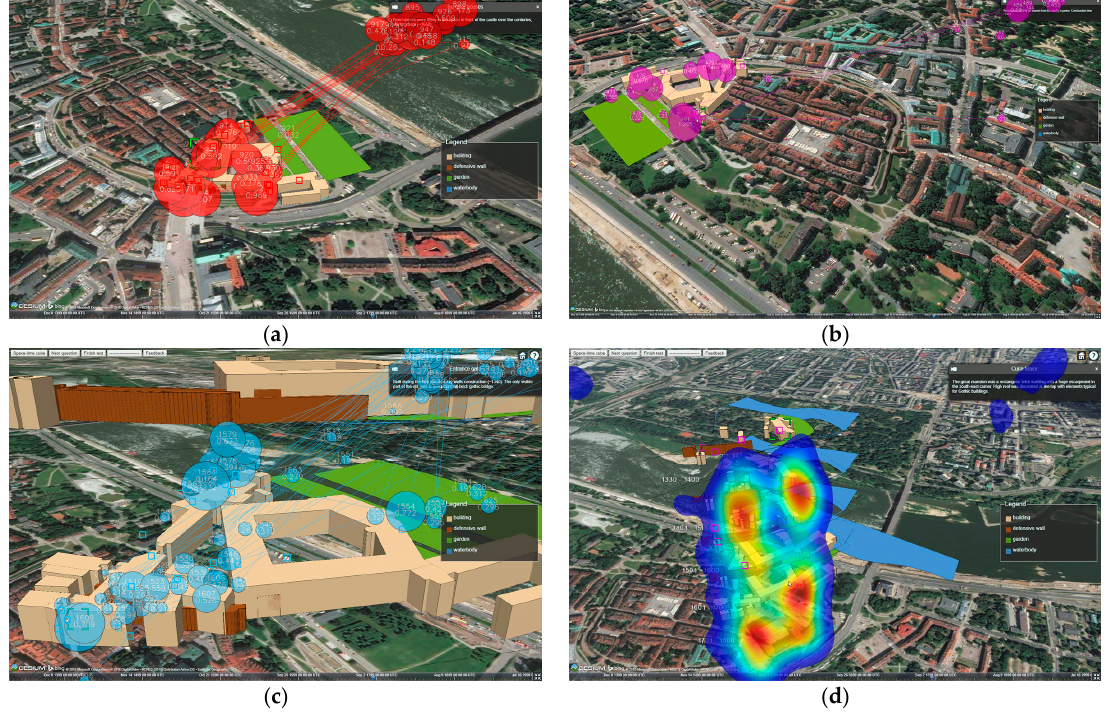
Figure 17. Searching strategies for Q4: ( a ) overview and details-on-demand in the slider-based visualization; ( b ) overview and details-on-demand in the slider-based visualization; ( c ) zoom and details-on-demand operations in the space–time cube; ( d ) overview and relate operations in the space–time cube.